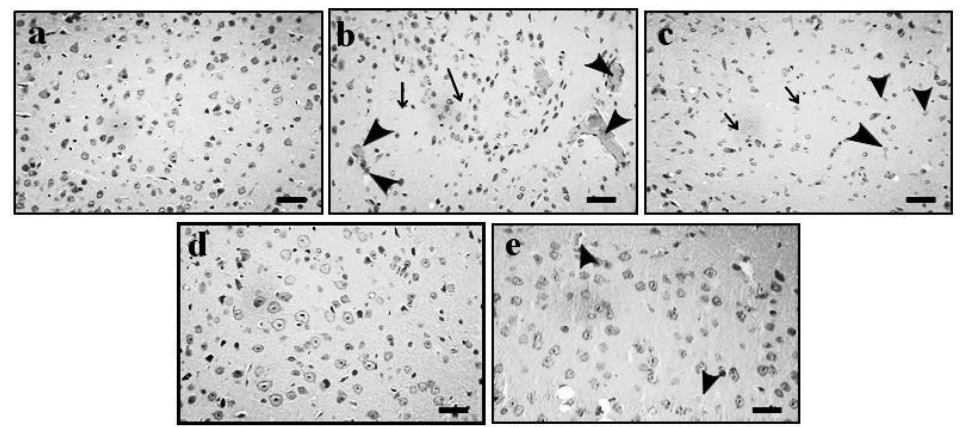
Figure 4. Effect of GE on AD-induced histopathological changes in the cortex region of the mouse brain. ( a – e ) Histopathological images of coronal sections of mouse brain tissue of normal, AD, and GE (2 and 4 mg/kg)- and DP (2 mg/kg)-treated groups, respectively. ( a ) Normal arrangement in cortex regions of the mouse brain. The thin arrow shows neuron loss and neurofibrillary degeneration and neuronophagia, the thick arrow shows nuclear pyknosis, and the arrowhead shows vacuolation in cortex regions. ( b ) Typical colliquative necrosis, characterized by disrupted cell membranes, fragmented nuclei, and inflammatory cells, indicating that the A β oligomer causes neuronal structural pathological injuries in mice. ( c – e ) Reversal of A β 1–42 -oligomer induced histopathological changes. Microscopic examinations were performed under 400 × light microscopy; scale bar = 35 µ